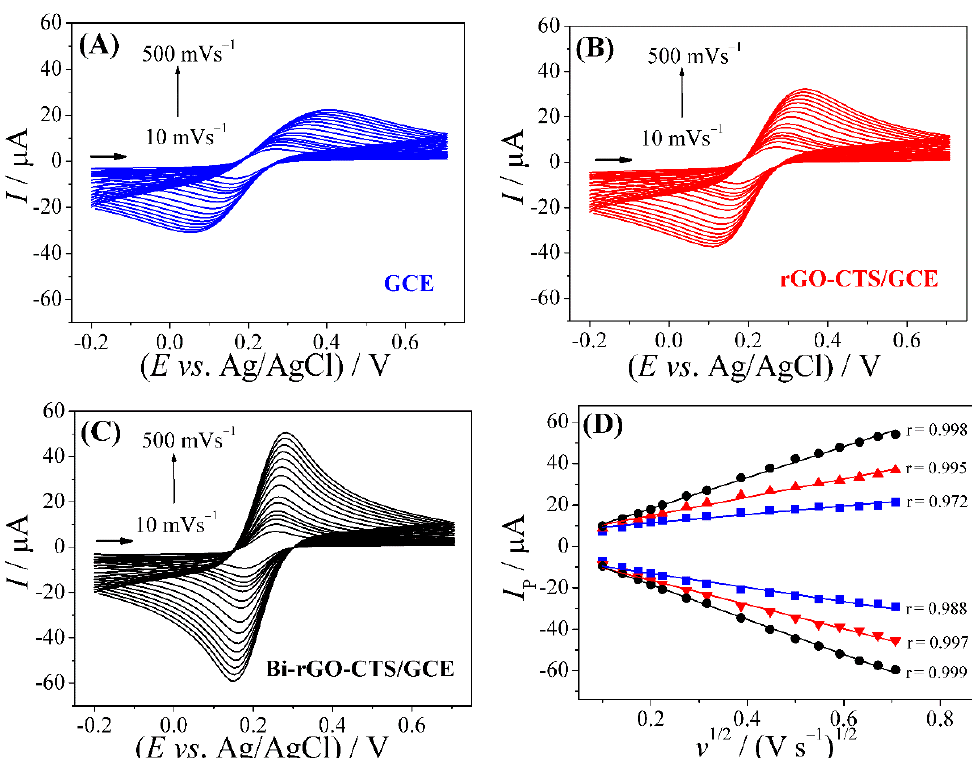
Figure 4. Analysis of the scan rate of the ( A ) GCE, ( B ) rGO-CCTS/GCE and ( C ) Bi-rGO-CTS/GCE electrodes using 0.1 mol L − 1 KCl solution in the presence of redox probe [Fe(CN) 6 ] 3 − /4 − (1.0 mmol L – 1 ) at different potential scan rates (10–500 mV s − 1 ). ( D ) I p vs. ν 1/2 .